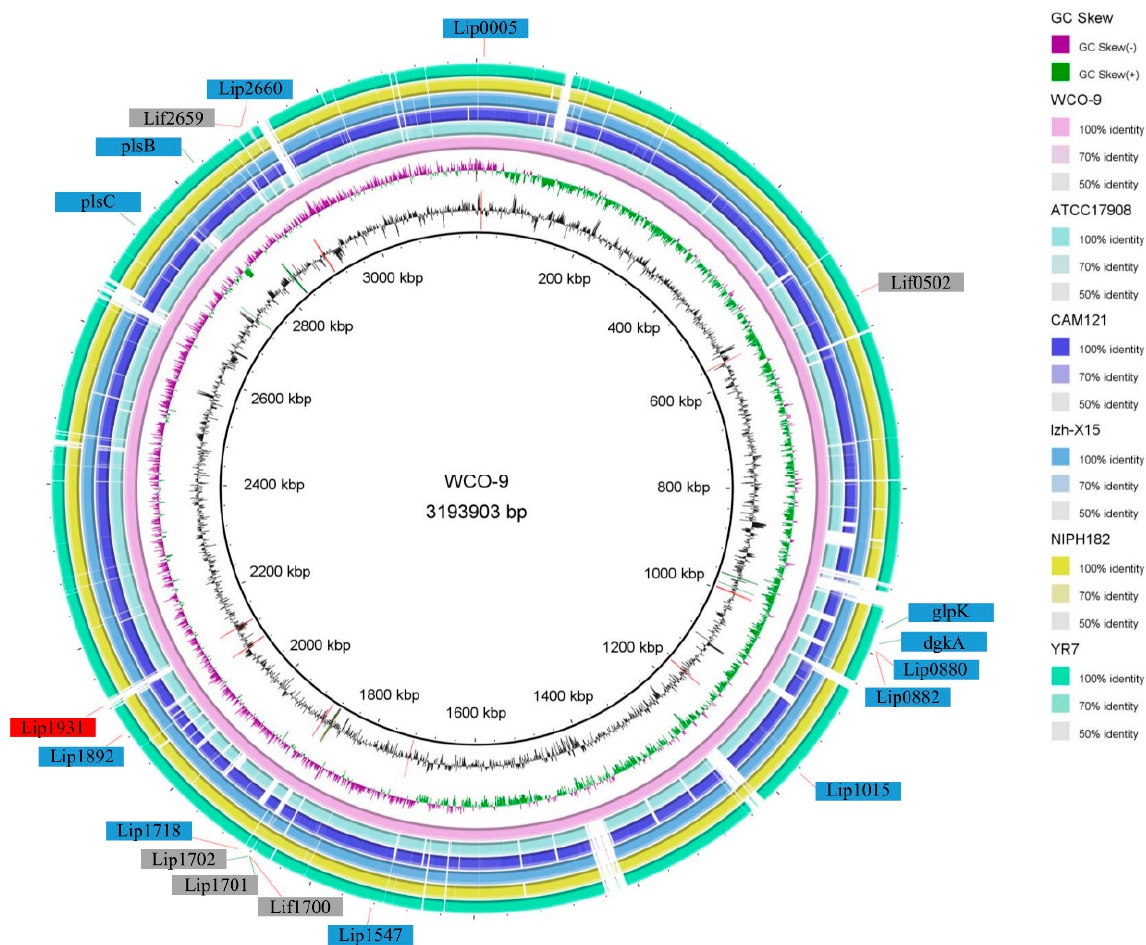
Figure 6. Comparison of lipase, chaperone and triacylglycerol degradation pathway genes between five strains of WCO-9 and other A. junii . The outermost circle is the annotation of lipase, lipase chaperone and triacylglycerol degradation pathway genes. The blue box indicates that the gene is present in all 11 strains, and the grey box indicates consistency of this gene in the ATCC 17,908 genome below 50% or not present compared with the WCO-9 strain, and the red box shows the specific lipase gene for strain WCO-9.